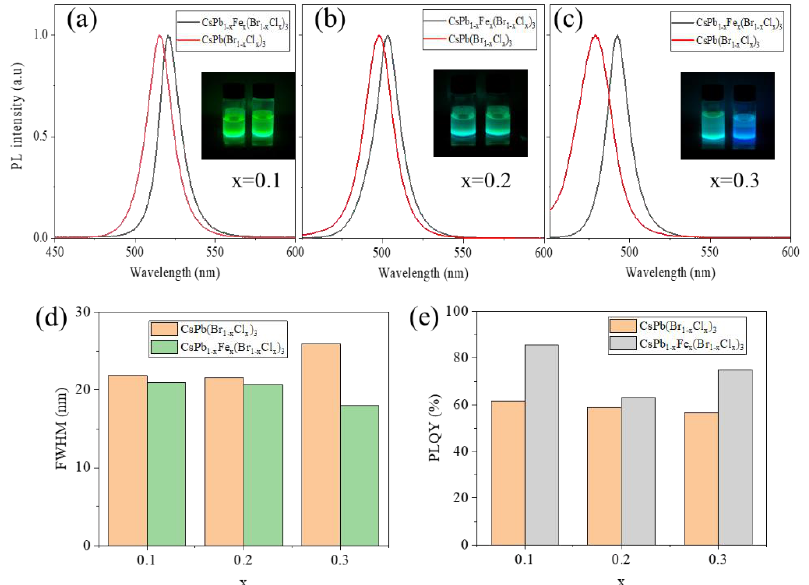
Figure 4. ( a – c ) Comparison of PL spectra of the CsPb 1 − x Fe x (Br 1 − x Cl x ) 3 and CsPb(Br 1 − x Cl x ) 3 NC solutions with x = 0.1 ( a ), 0.2 ( b ), and 0.3 ( c ). ( d ) FWHM of the two kinds of NCs with different x values. ( e ) PL QY of the two kinds of NCs with different x values.